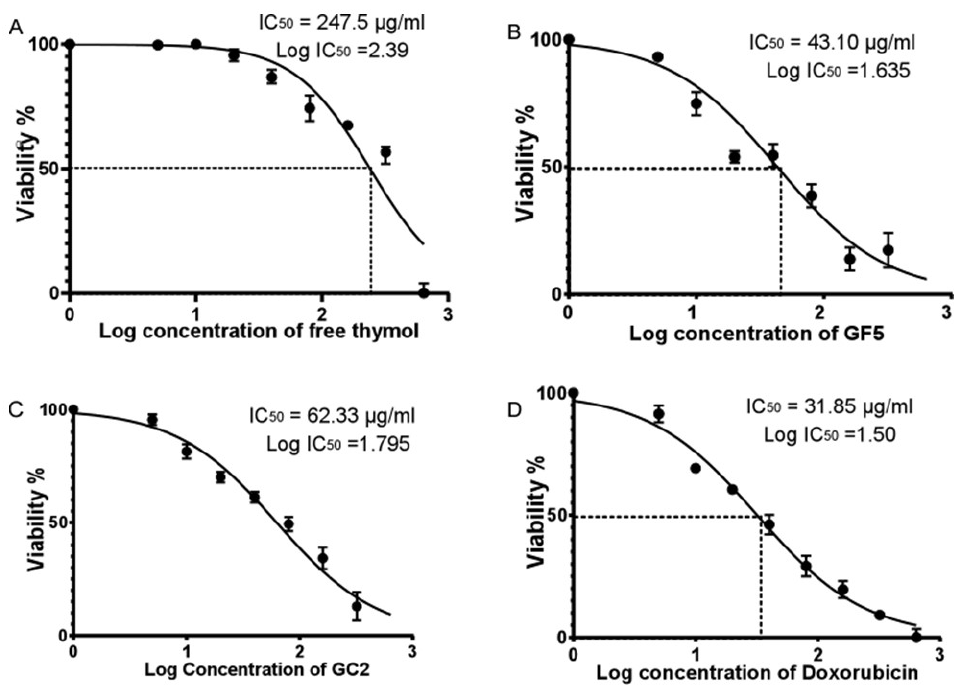
Figure 7. Half maximal inhibitory concentration (IC 50 ) of free thymol hydrogel, GF5, GC2, and Doxorubicin against normal human skin cell line (BJ-1) using the SRB colorimetric assay. Figures ( A – D ) represent the percentage of cell viability of BJ-1 cells against different concentrations of free thymol, GF5, GC2 and Doxorubicin, respectively. Error bars represent the standard error. A p value < 0.05 was considered significant.